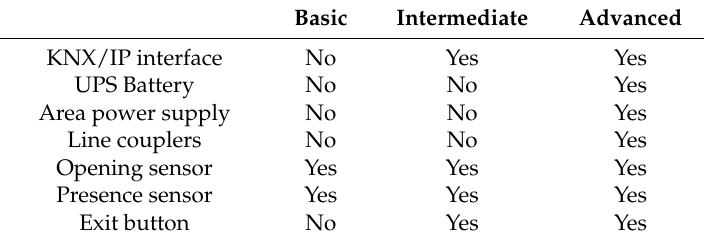
Table 11. Elements of security subsystem in common with the other systems.